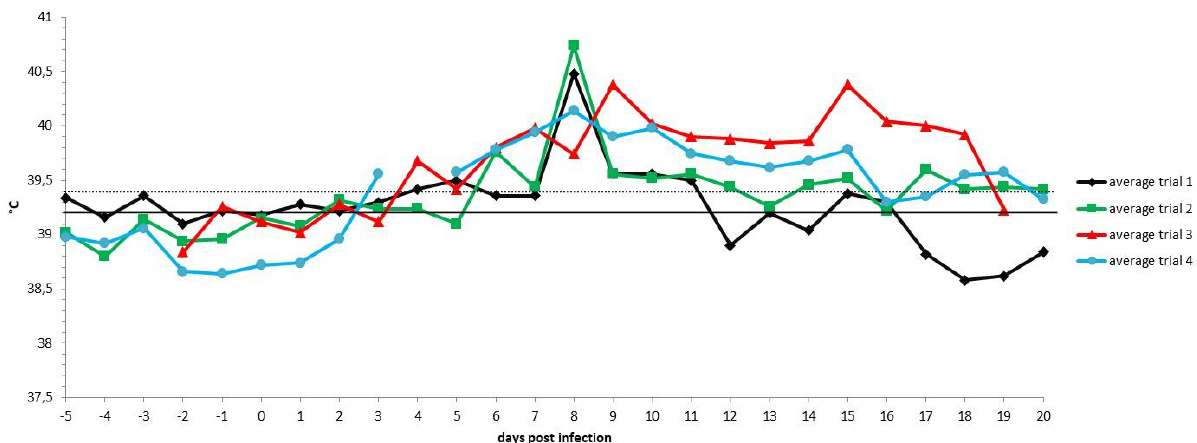
Figure 1. Averaged body temperatures per trial of the control animals. Solid line: fever cut-off for consecutive days; dotted line: fever cut-off for isolated fever days.